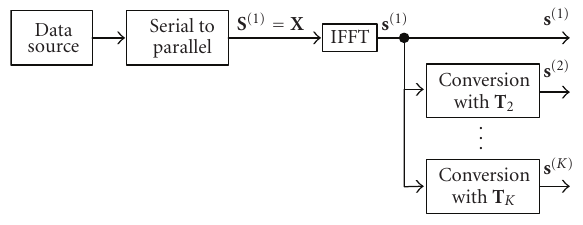
Figure 1: Idea of conversion with T r for IFFT computation.